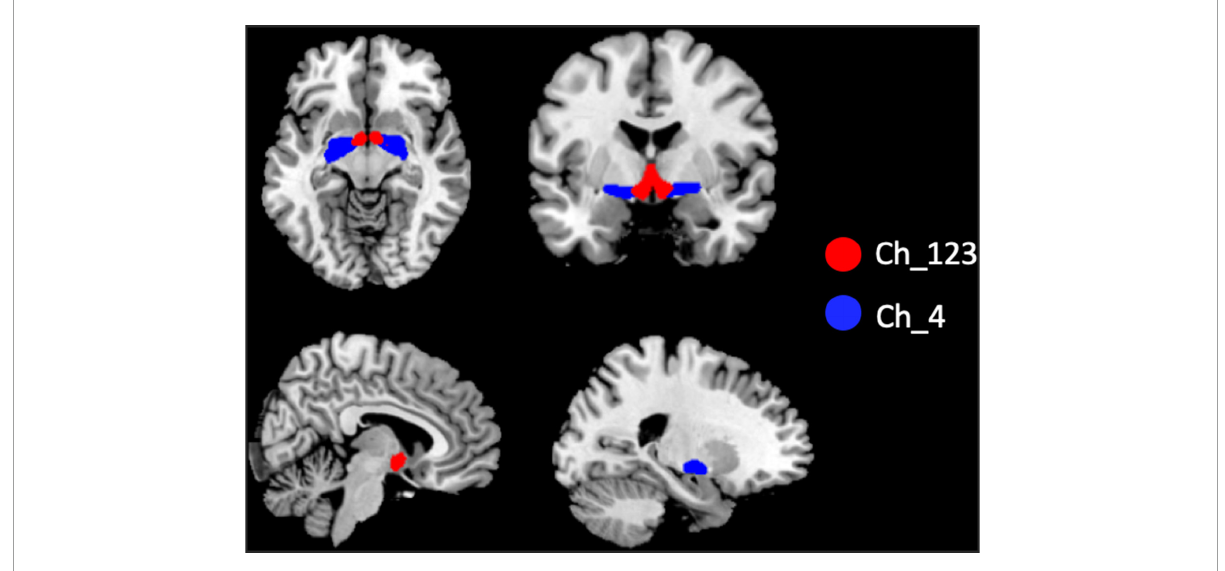
FIGURE1 Illustration of the locations of basal forebrain (BF) subregions. The red color represents Ch_123; the blue color represents